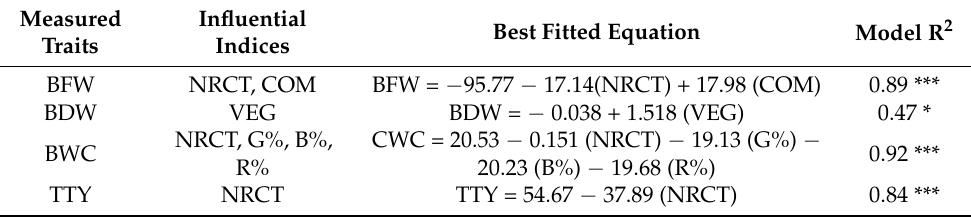
Table 3. Extraction of the Most Influential Thermal and RGB Imaging Indices ACCOUNTING for the Major Variation for Biomass Fresh Weight (BFW) Biomass Dry Weight (BDW), Biomass Water Content (BWC), and Total Tuber Yield (TTY) Using Stepwise Multiple Linear Regression (SMLR) Analysis and Based on 75% of Dataset (n = 36).